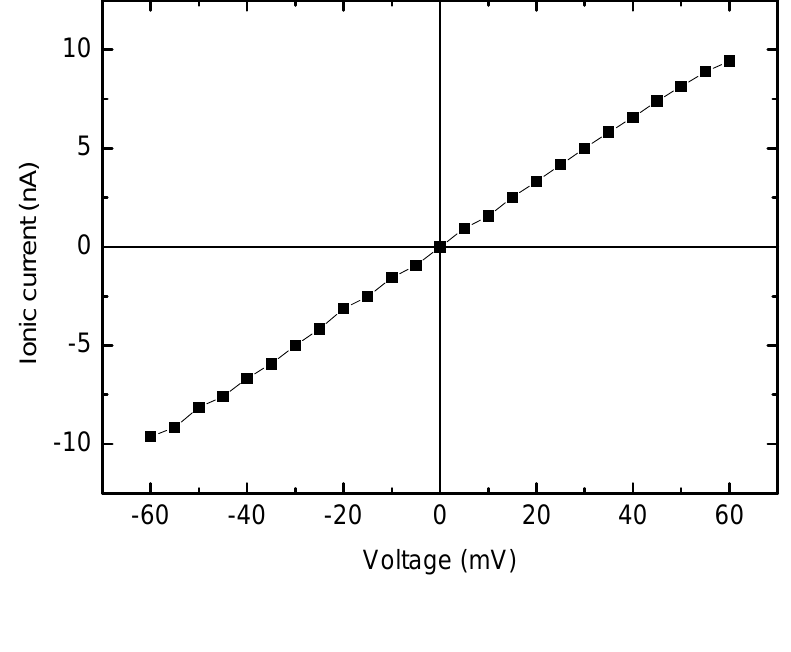
Figure 3. A measurement of the ionic current vs. applied voltage through the solid-state